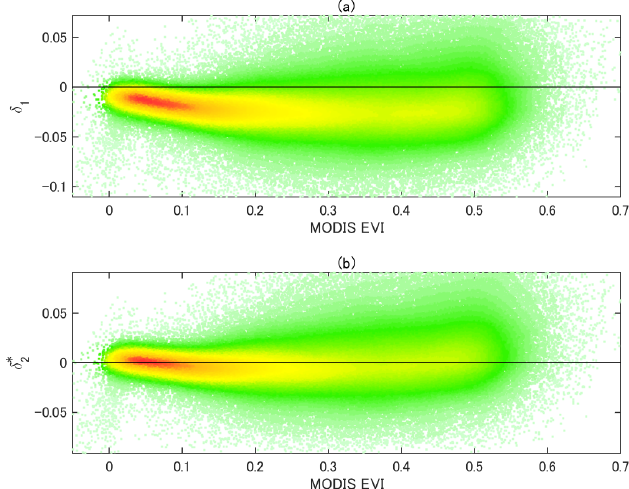
Figure 3. Density plots of EVI differences using the data for the calibration. ( a ) Density plot of MODIS EVI minus VIIRS EVI ( δ 1 ) vs. MODIS EVI; ( b ) Density plot of MODIS EVI minus MODIS-compatible VIIRS EVI ( δ ˚ ) vs. MODIS 2 Table 2. Statistics of MODIS EVI minus VIIRS EVI ( δ (cid:2869) ) and MODIS EVI minus MODIS-compatible VIIRS EVI obtained in the optimization ( δ (cid:2870)∗ ).